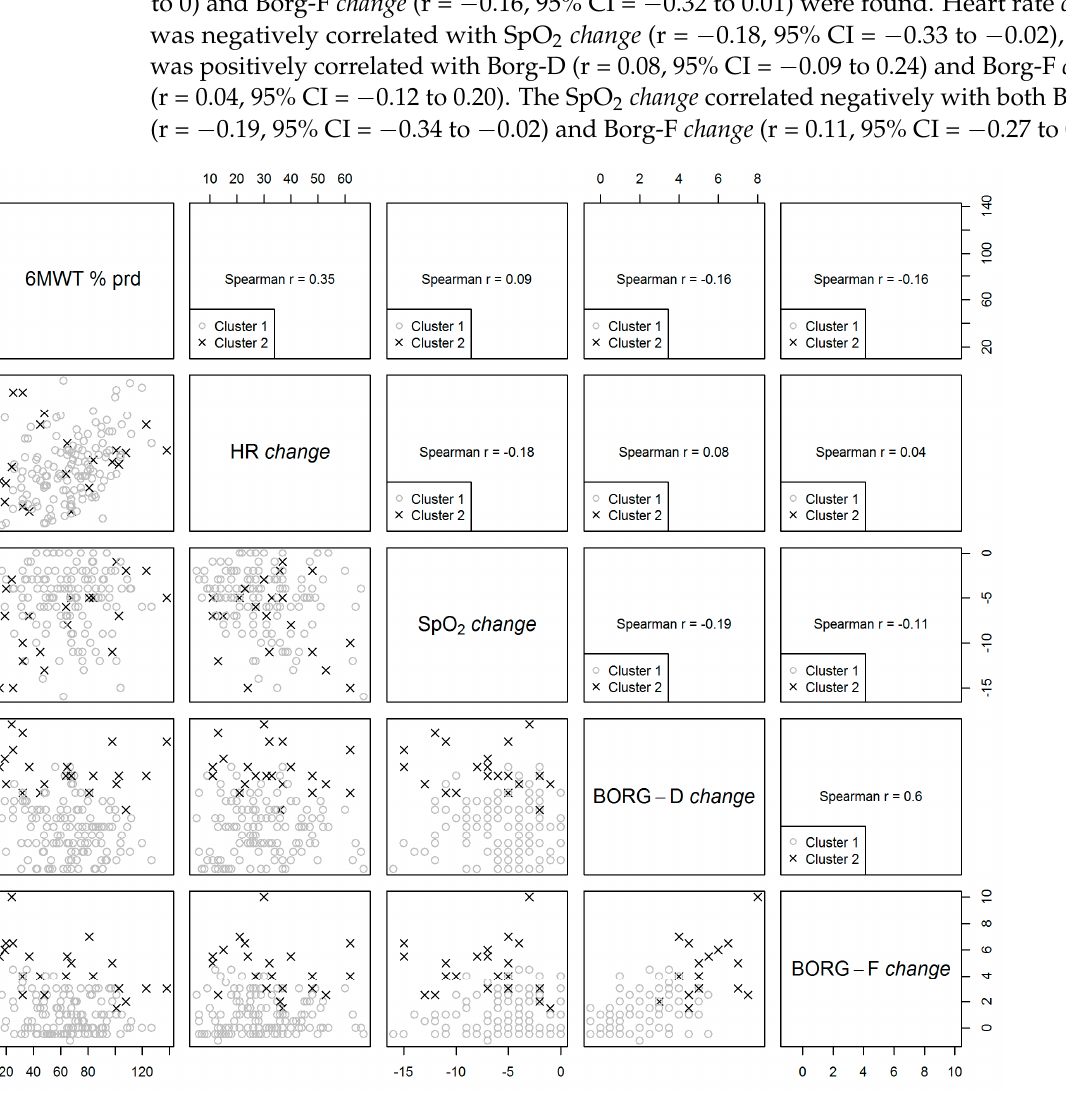
Figure 1. Scatterplot matrix of variables used for clustering analysis.